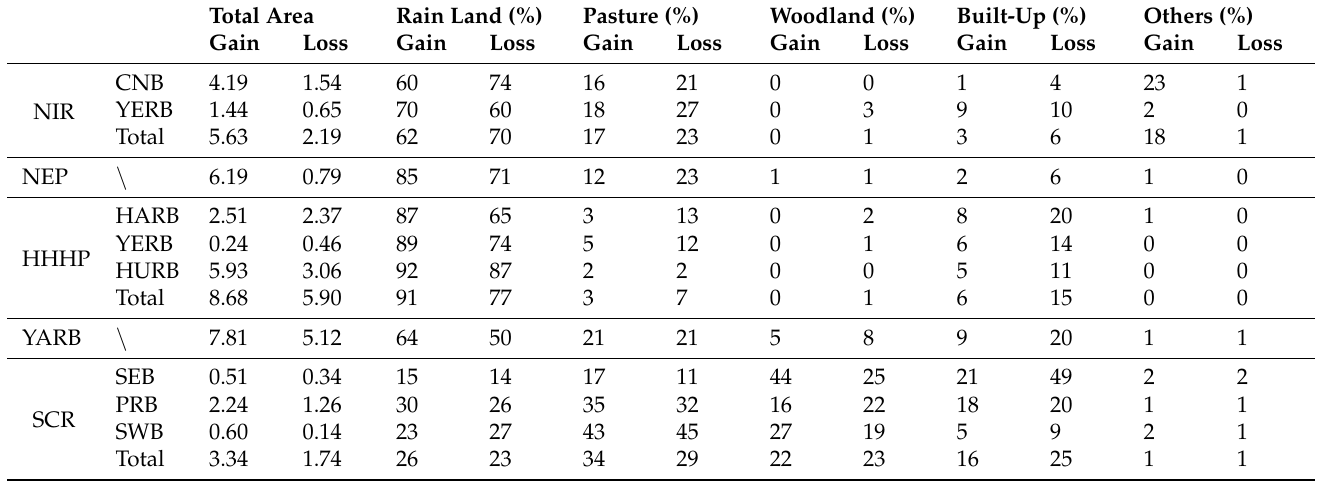
Table 5. Land-use transition patterns caused by irrigated cropland changes in China during 2000–2019. Total Area Rain Land (%) Pasture (%) Woodland